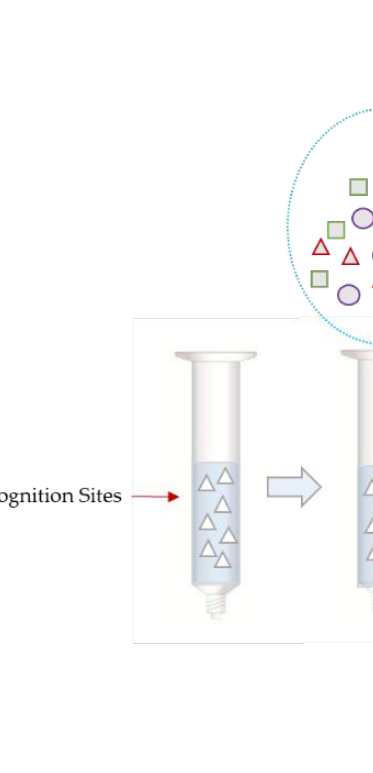
Figure 2. Molecular imprinting process.